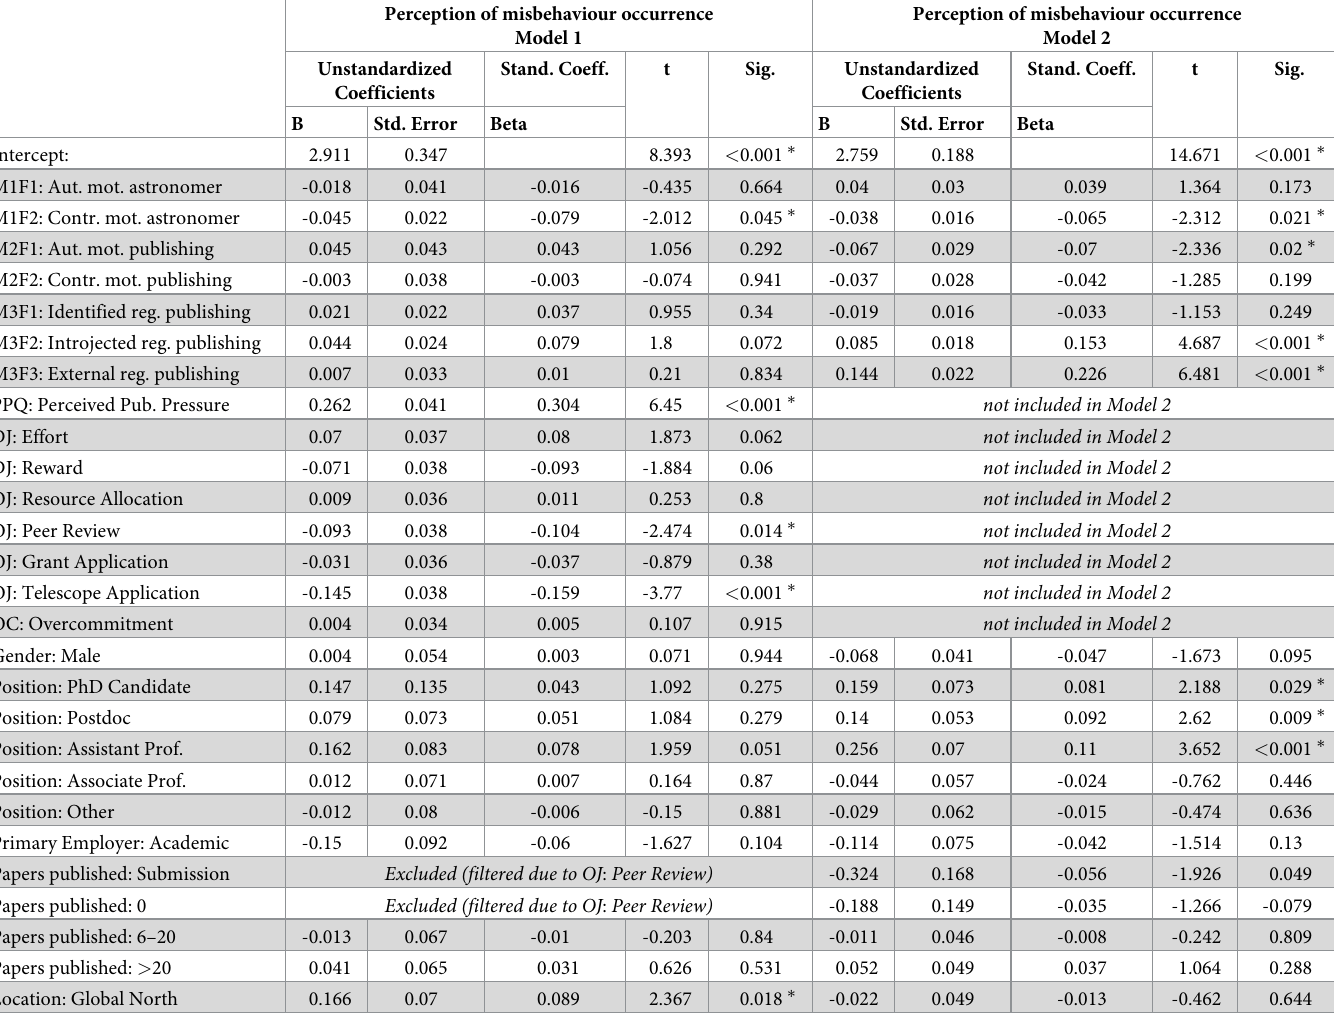
Table 9. Regression models of DV = perception of frequency of misbehaviour occurrence. Model 1: DV is regressed onto the seven motivational factors, perceived publication pressure, distributive justice & organizational, overcommitment, and the control variables. Model 2: DV is regressed onto the seven motivational factors and the control variables.